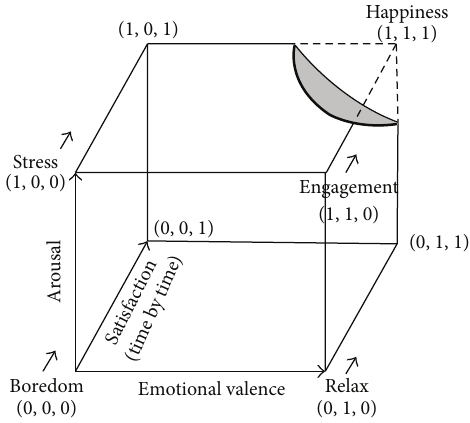
Figure 2: Arousal-Valence-Satisfaction space, identifying on frontal plan the valence-arousal model. The happiness is an extension of the engagement state with a higher level of life